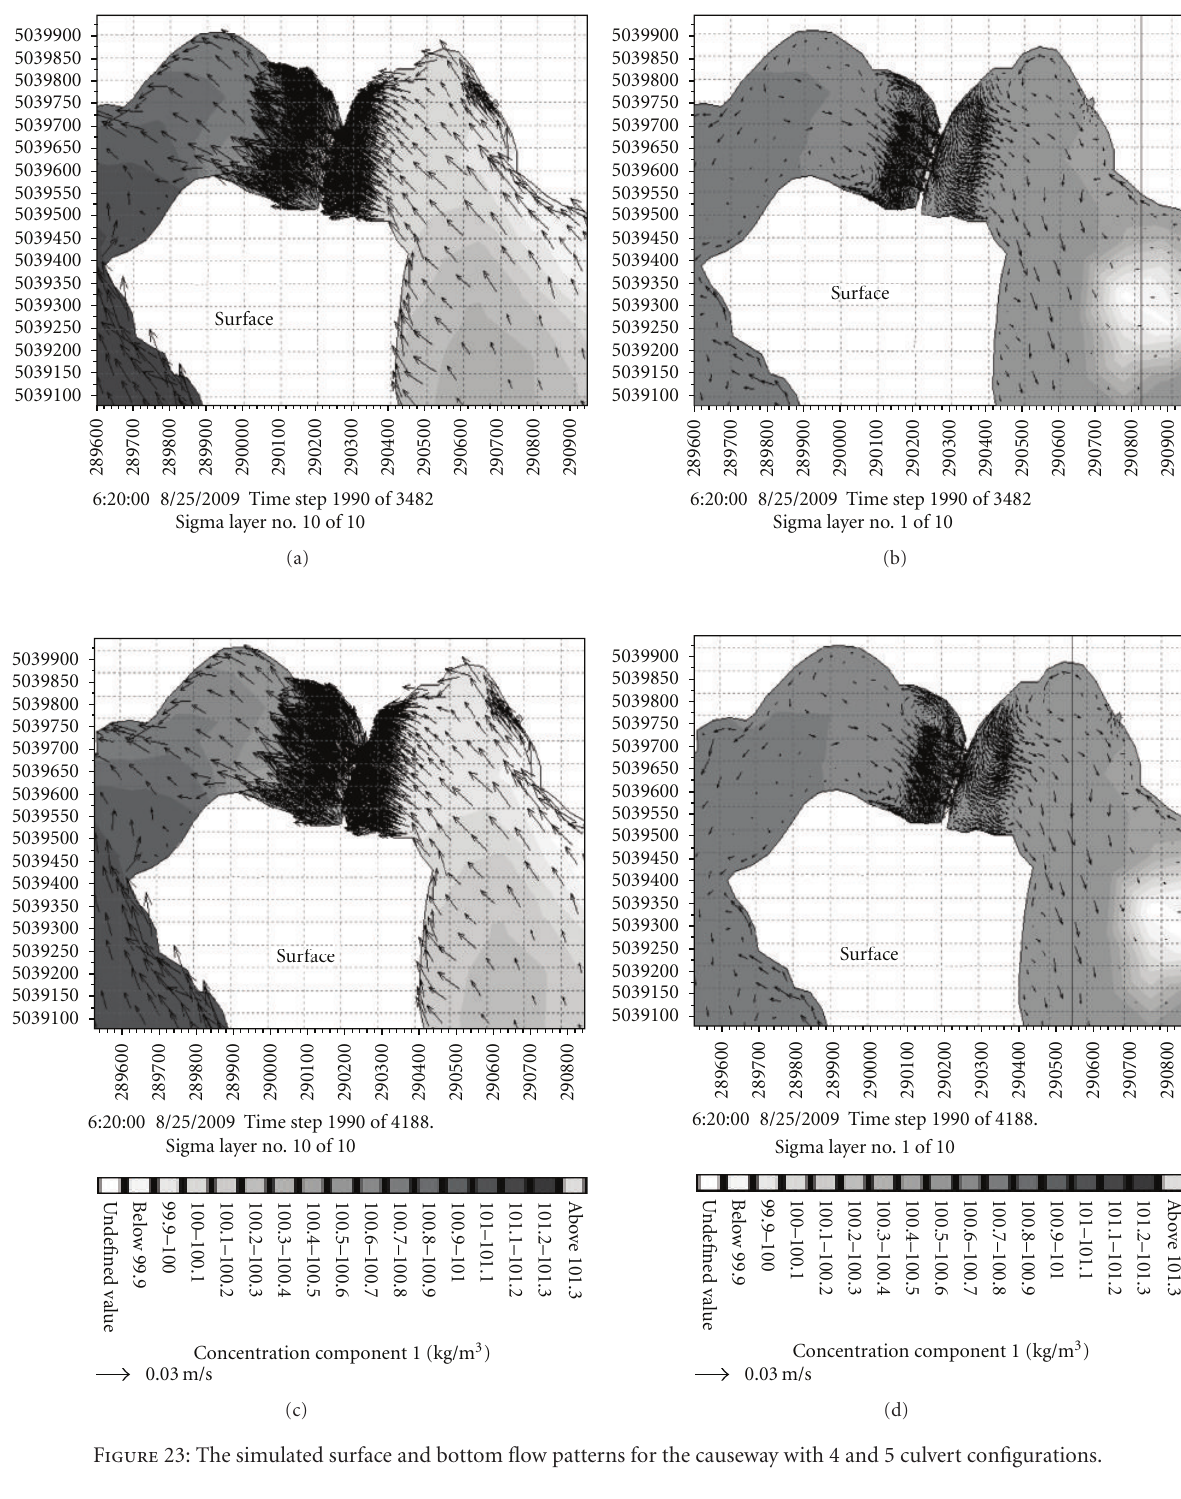
are very similar. From the hydraulic point of view, there are no real di ff erences between the two flow conditions; neither one would alter the present circulation pattern of the lake and would be not likely to induce any large flow circulation pattern around Mask